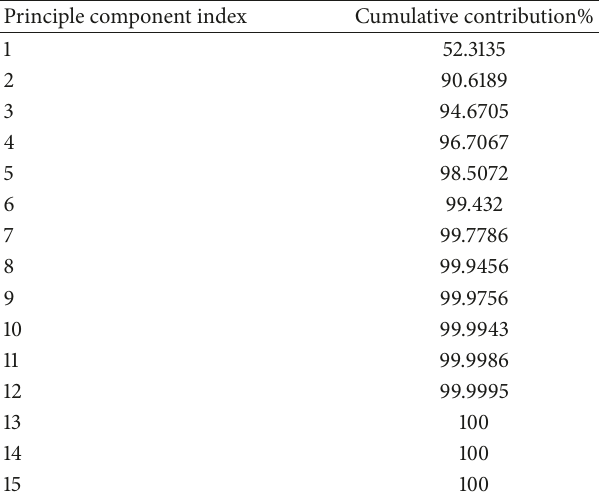
Table 3: Accumulated contribution rate of each